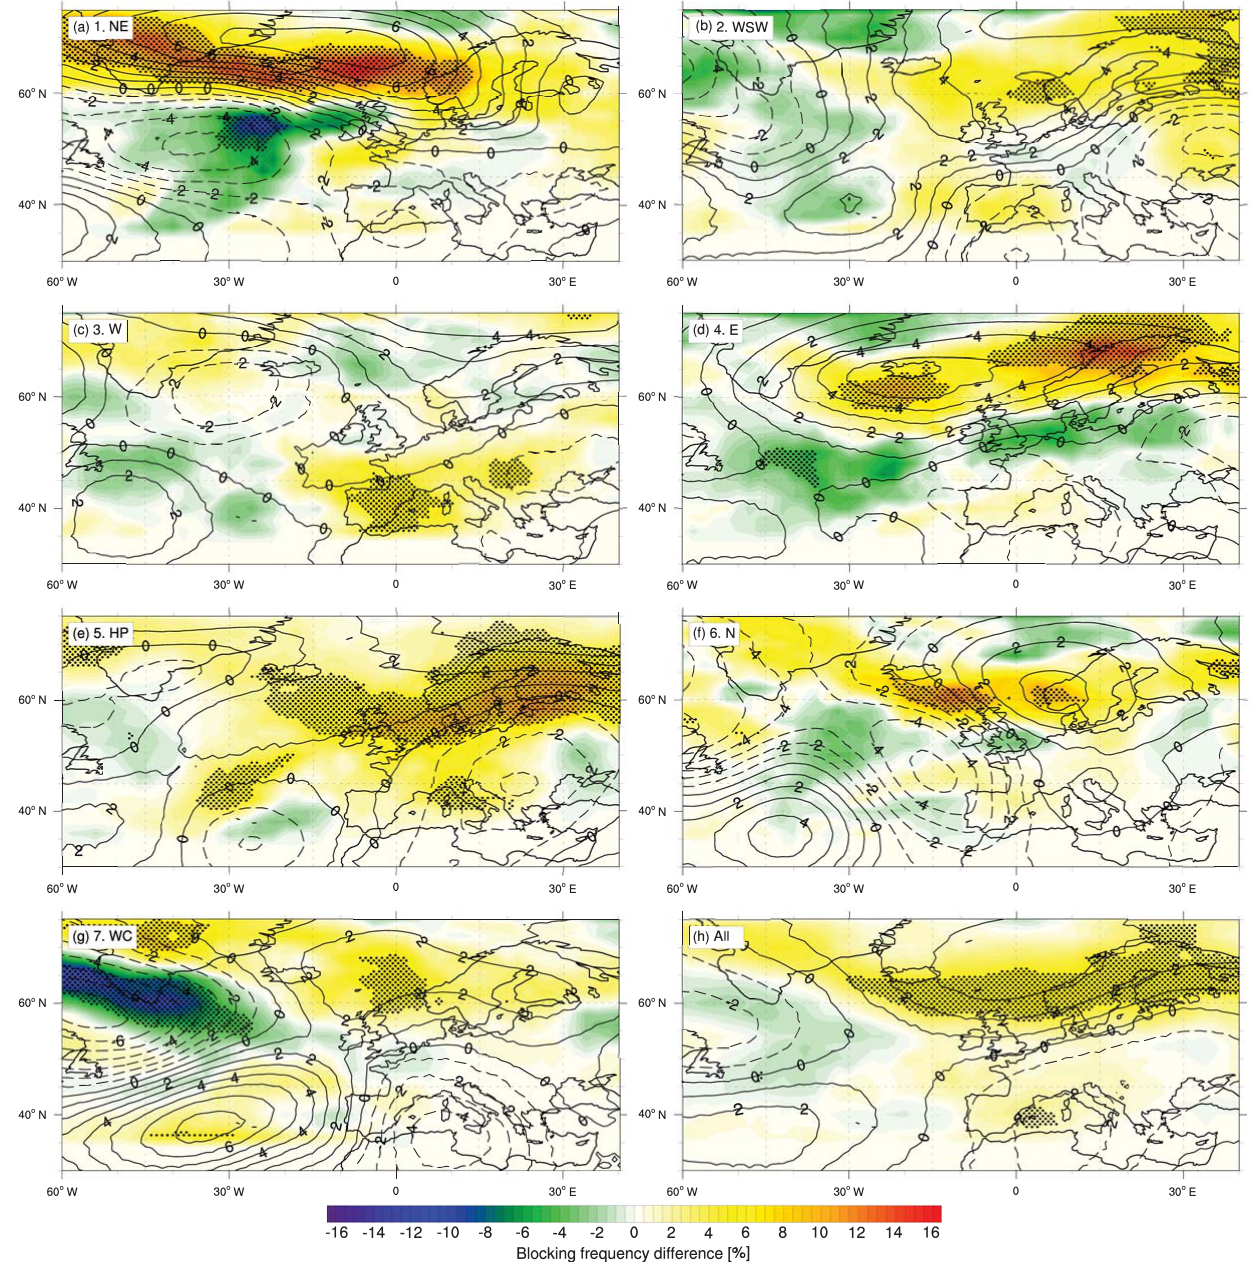
Figure 7. CAP7 (1 to 7) and mean (All) JFM blocking frequency (colour) in % and 500hPa geopotential height (contour) in gpdm difference between low and high solar activity (low minus high) computed with ERA-40/Interim for the period 1958–2009. The 95% significance level is indicated by stippled areas.